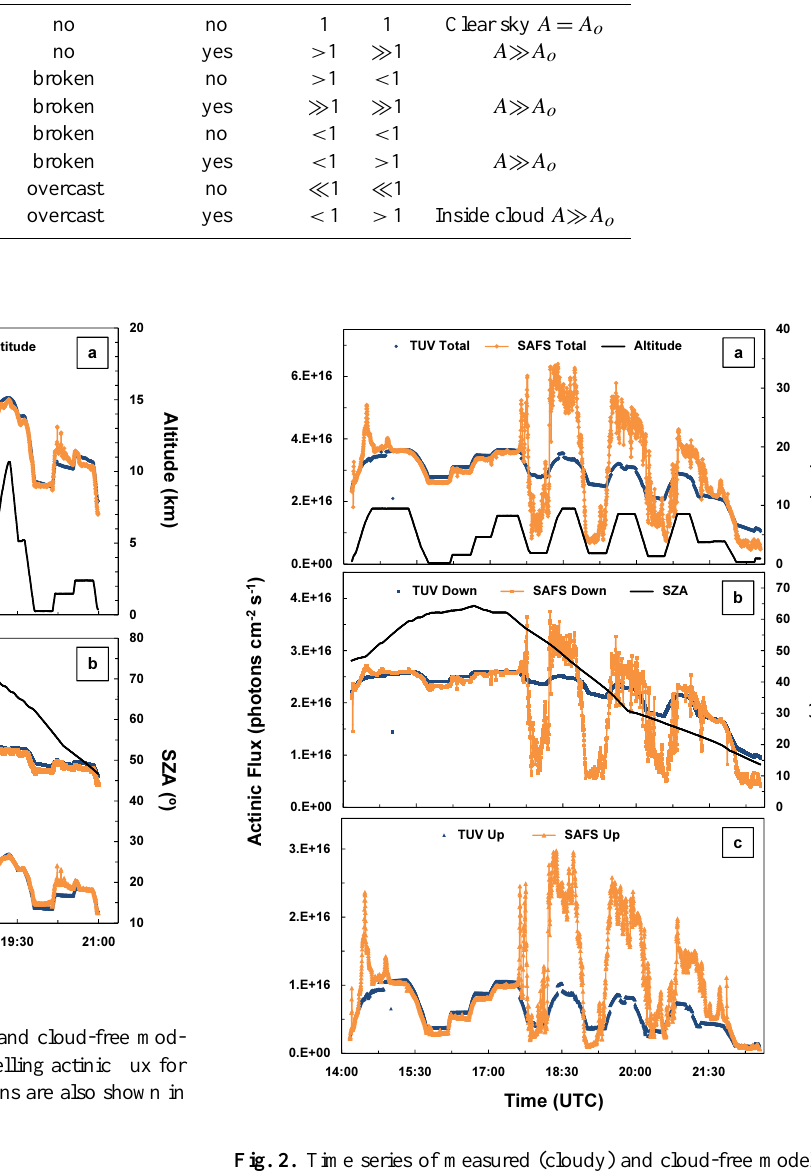
Fig. 2. Time series of measured (cloudy) and cloud-free modeled (a) total, (b) down-welling, and (c) up-welling actinic flux for 7 Au- gust. Aircraft altitude and SZA variations are also shown in panels (a) and (b) ,